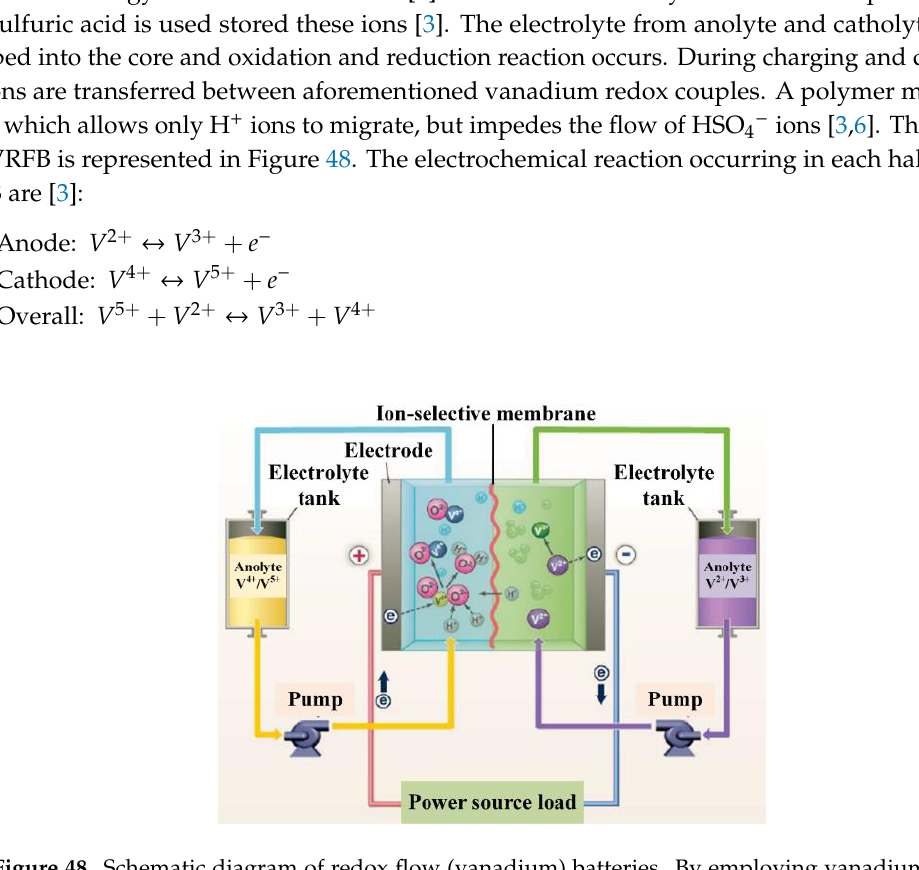
Figure 48. Schematic diagram of redox flow (vanadium) batteries. By employing vanadium redox couples V2+/V3+ in the negative and V4+/V5+ in the positive half-cell, the energy is stored in the vanadium redox flow batteries (VRFB) [3].